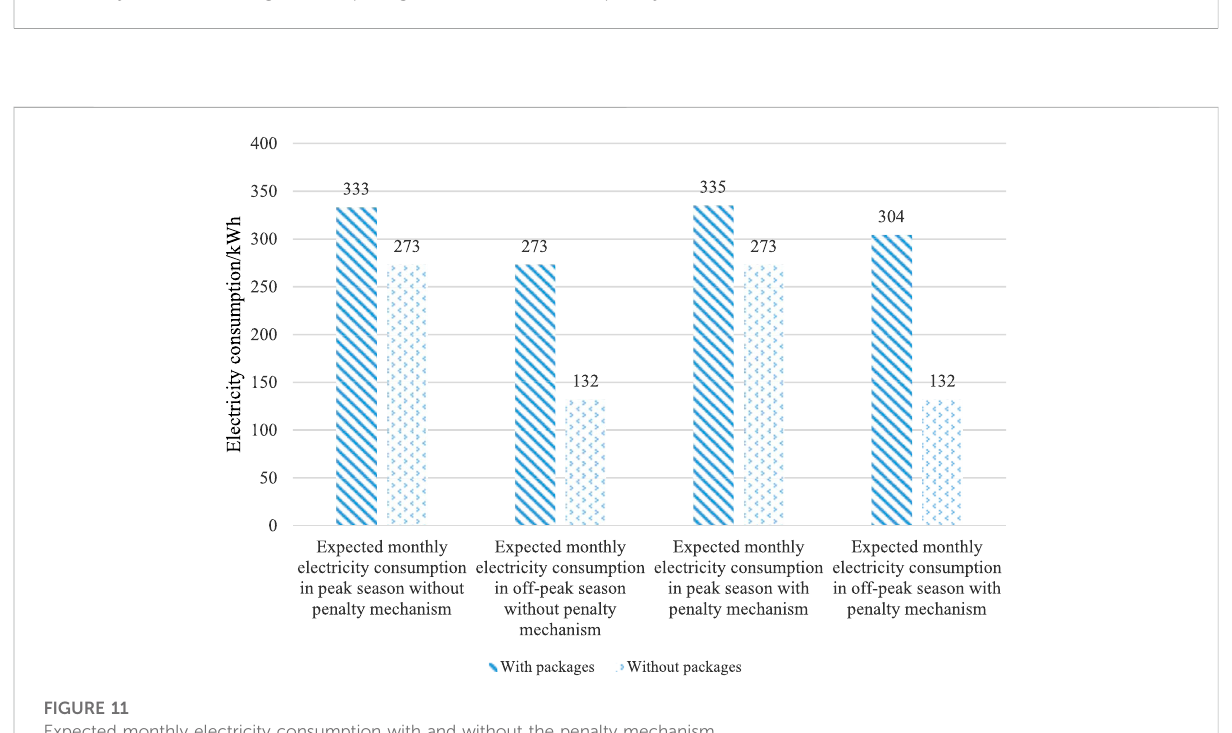
FIGURE 11 Expected monthly electricity consumption with and without the penalty